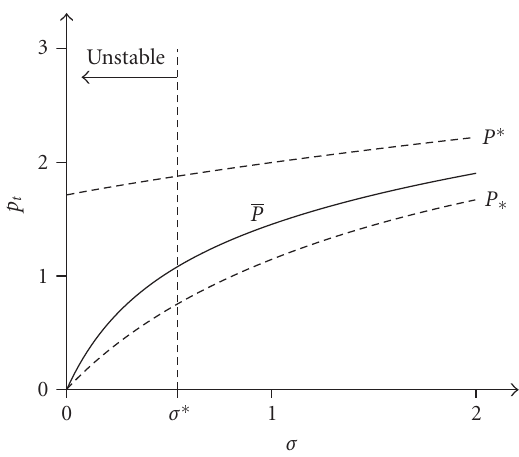
Figure 4.2. Critical price values: m =